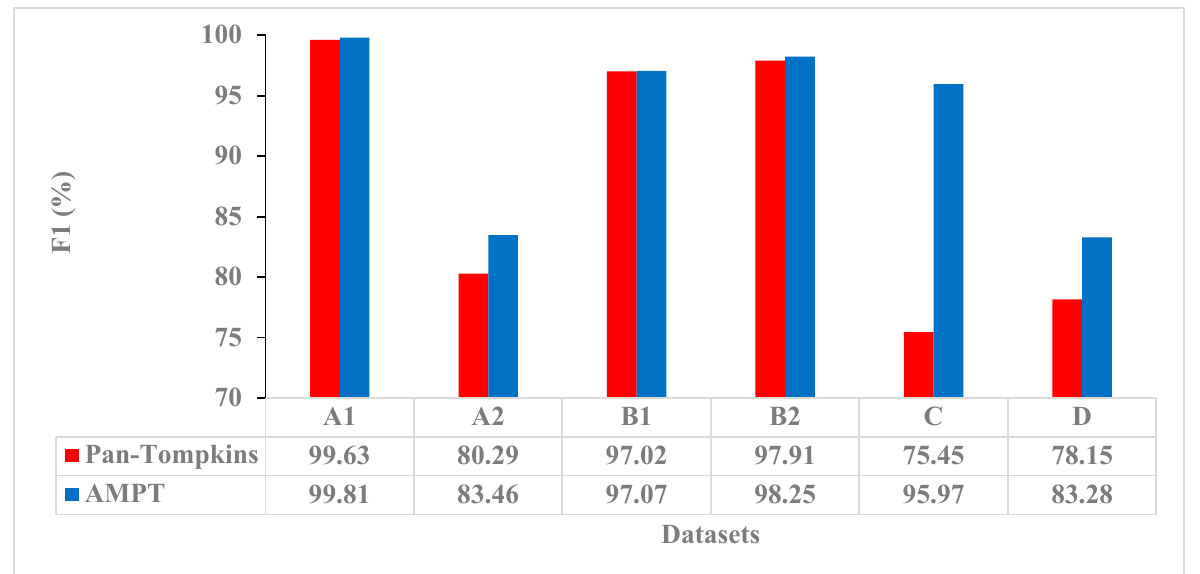
Figure 1. Processing times per ten seconds of ECG data for the Pan–Tompkins (red) and AMPT (blue) algorithms with their efficiency factors (green) by dataset. A1 = High Quality, A2 = Low Quality, B1 = Normal Sinus Rhythm, B2 = Arrhythmias, C = Paced Rhythm, and D = TeleHealth datasets.